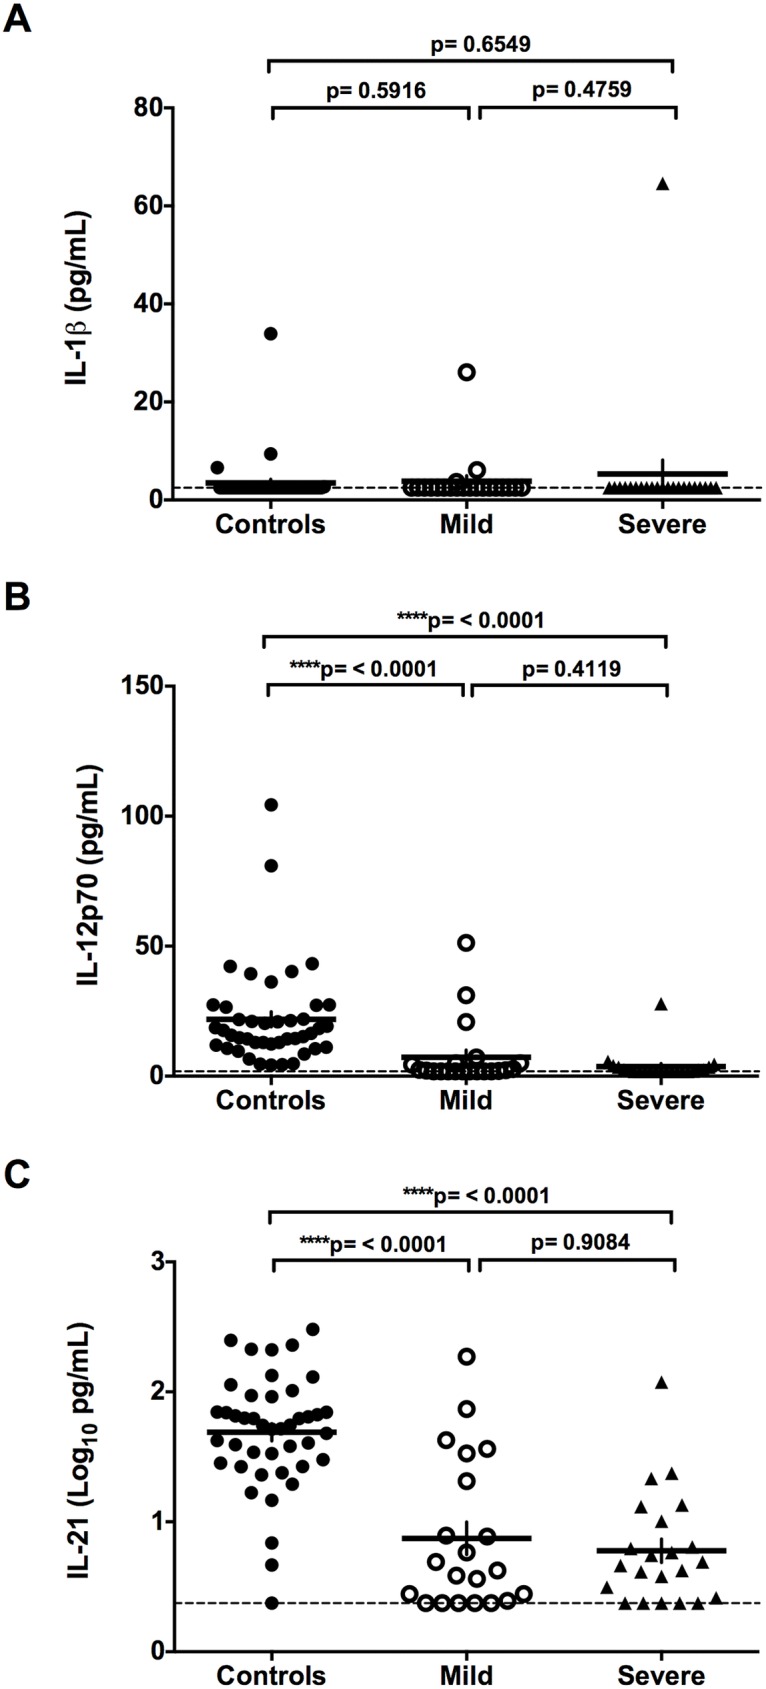
IL-1β, IL-12p70, and IL-21 levels in control and ANDV-infected patients.Circulating levels of cytokines (A) IL-1β, (B) IL-12p70 and (C) IL-21 in serum samples of Control individuals and ANDV-infected patients with Mild or Severe disease progression are represented by dots. IL-1β and IL-12p70 were expressed in pg/mL while the circulating levels of IL-21 are expressed as Log10 (pg/mL) to facilitate comparison between the groups. A Mann-Whitney test for continuous variables was performed to evaluate significant differences between Controls and Mild or Severe, and Severe versus Mild groups. The ends of the brackets indicate the compared groups. The dashed line represents the lower limit of detection. Each serum sample was analyzed in duplicate in the same plate.